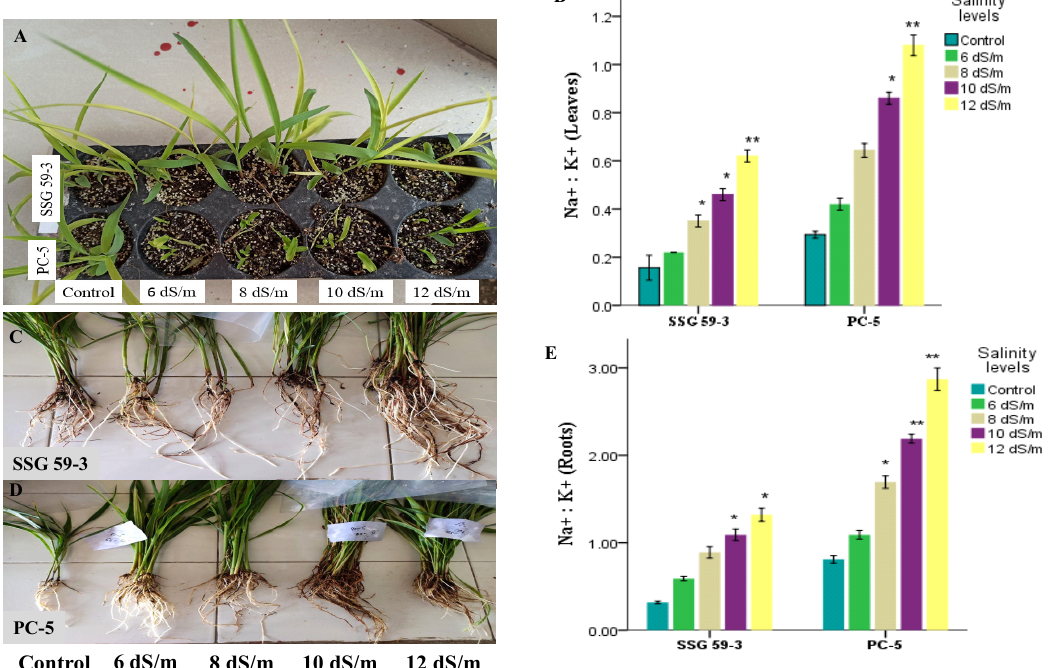
Figure 5. Effect of salt stress on ion profiling of sorghum genotypes. ( A ) Seedlings of SSG 59-3 (salt-tolerant) and PC-5 (salt-sensitive) genotypes after 48 h of salt exposure, ( B ) Na + /K + ratios in leaves, ( C ) root biomass of SSG 59-3 (salt-tolerant), ( D ) root biomass of PC-5 (salt-sensitive) genotype, and ( E ) Na + /K + ratios in roots. All values are the means ± SD of three biological replicates. Asterisks represent significant (*) and highly significant (**) differences among different treatments.